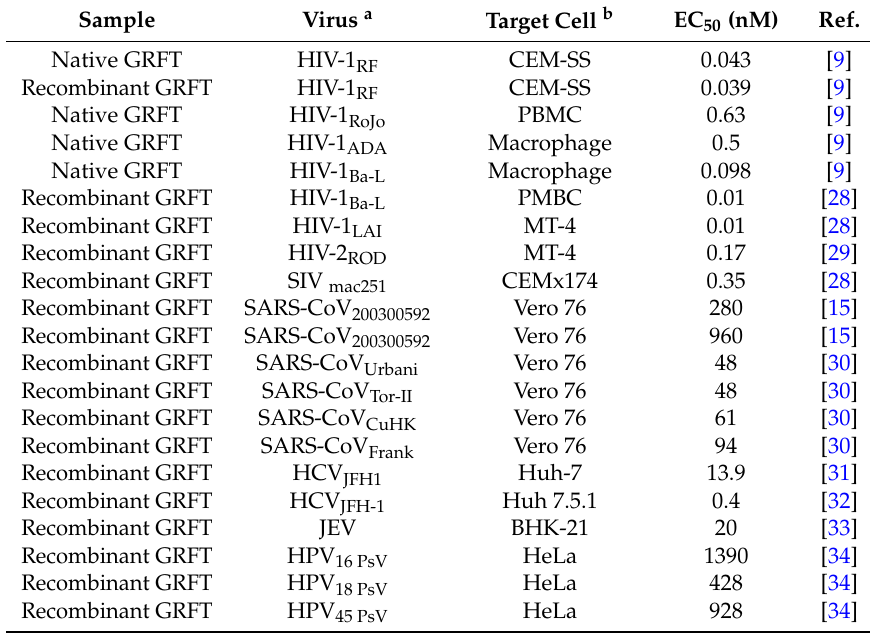
immunodeficiency virus; SARS ‐ CoV: severe acute respiratory syndrome corona virus; HCV: hepatitis C virus; JEV: Japanese encephalitis virus; HPV: humanpapillomavirus. b CEM ‐ SS: human T ‐ lymphoblastoid cell line; PBMC: peripheral blood mononuclear cell; BHK ‐ 21: baby hamster kidney fibroblasts; MT ‐ 4 human T cells isolated from a patient with adult T cell leukemia; CEMx174: somatic cell hybrid culture between CEM and B cell like 174 both of human origin; Vero 76: kidney epithelial cells extracted from an African green monkey; Huh: differentiated hepatocyte ‐ derived carcinoma cell line.